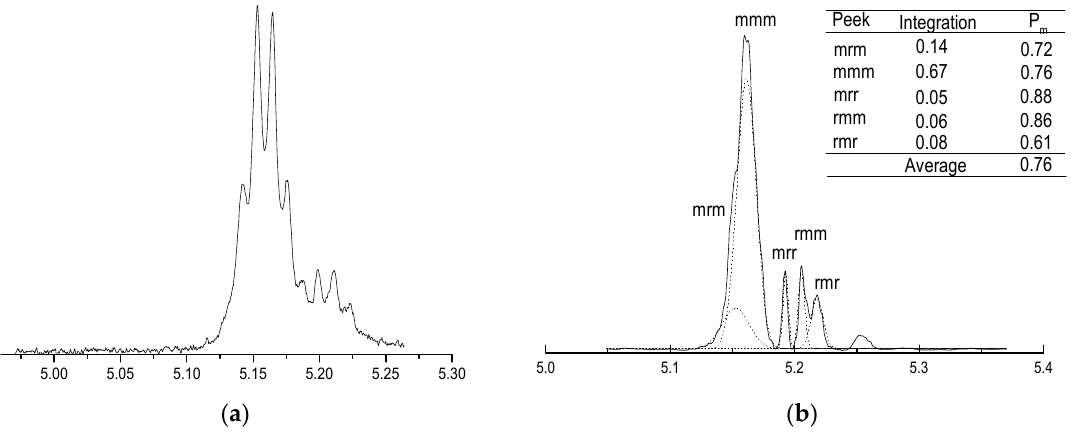
Figure 7. ( a ) 1 H NMR spectrum of rac -LA obtained by K2 (run 6, Table 3); ( b ) Homonuclear-decoupled 1 H NMR spectroscopy of rac -LA obtained by K2 (run 6, Table 3). The P m values were determined for all tetrads based on Bernoulli statistics, and their average value was used.